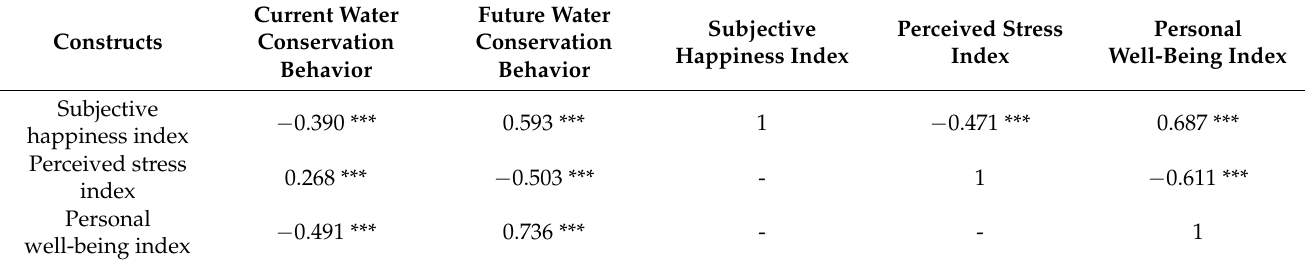
Table 3. Pearson correlations of psychosocial factors and water conservation